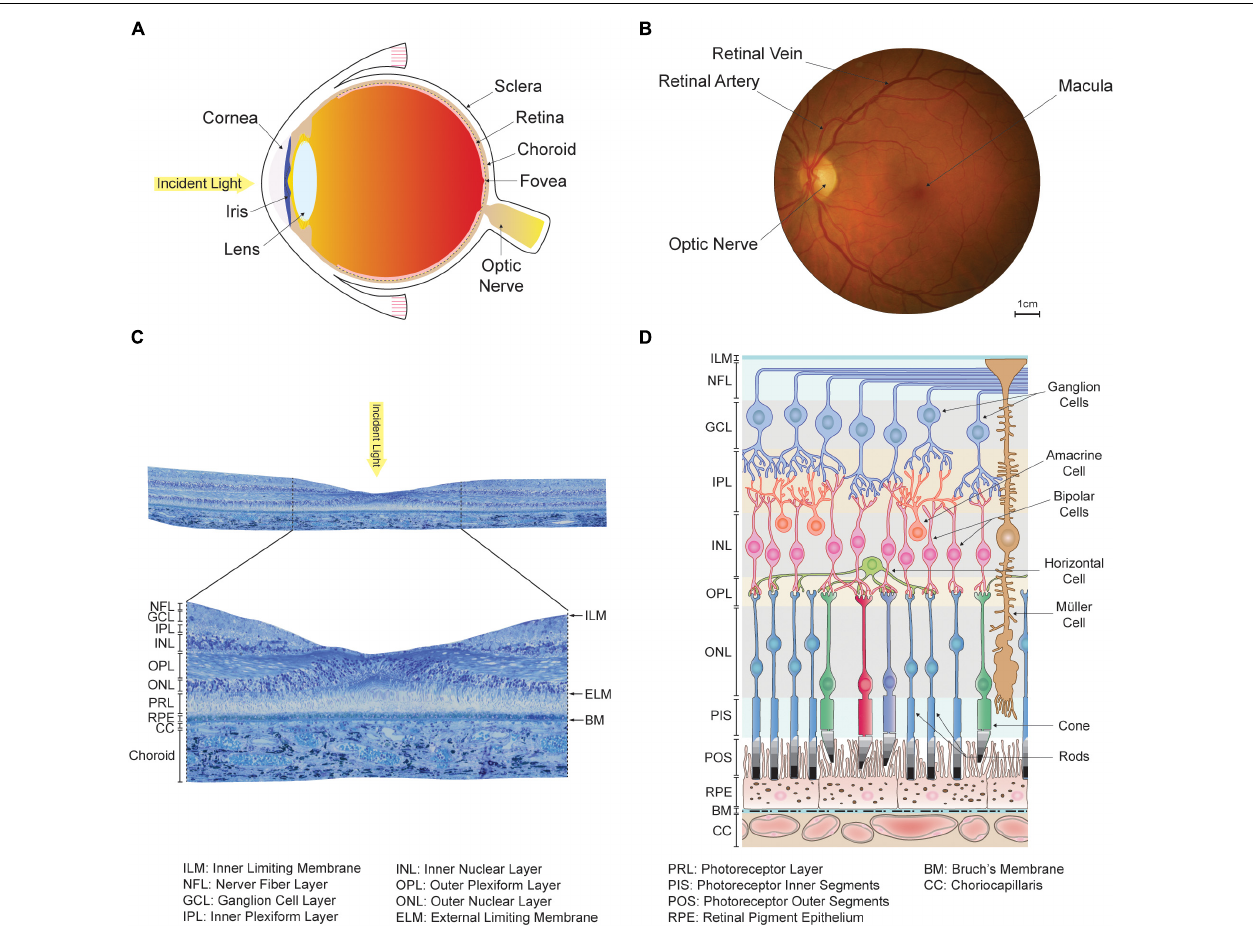
FIGURE 1 | Organization of the human eye and retina. (A) Schematic of a human eye. The anterior segments, which include the cornea, iris and lens, direct light toward the retina located in the back of the eye. (B) En-face view of the retina captured in a healthy individual using an ophthalmoscope. The optic nerve and large retinal arteries and veins are visible, but the underlying choroidal vasculature is not. The fovea, a region of the retina specialized for high-acuity and color vision, lies at the center of the approximately 5.5 mm wide macula. (C) View of a transverse section of the retina taken from a human donor eye in the macula. Histologically, the retina appears as layered tissue formed by retinal neurons, endothelium, and glial cells. (D) Schematic of the cellular organization of the retina and choriocapillaris, adapted and modified with permission from Campello et al. (2021). The location of histologically defined retinal layers is indicated. The outer retina consists of the retinal pigment epithelium and photoreceptor outer and inner segments. The inner retina includes horizontal, bipolar, amacrine and ganglion cells, which are all involved in the processing of signals originating from the